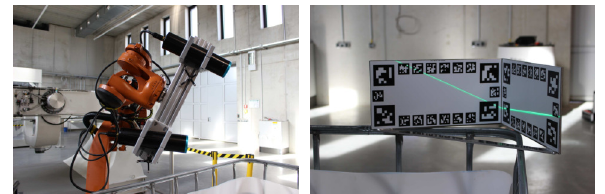
Figure 4. Calibration of the laser plane parameters using a L-shaped calibration